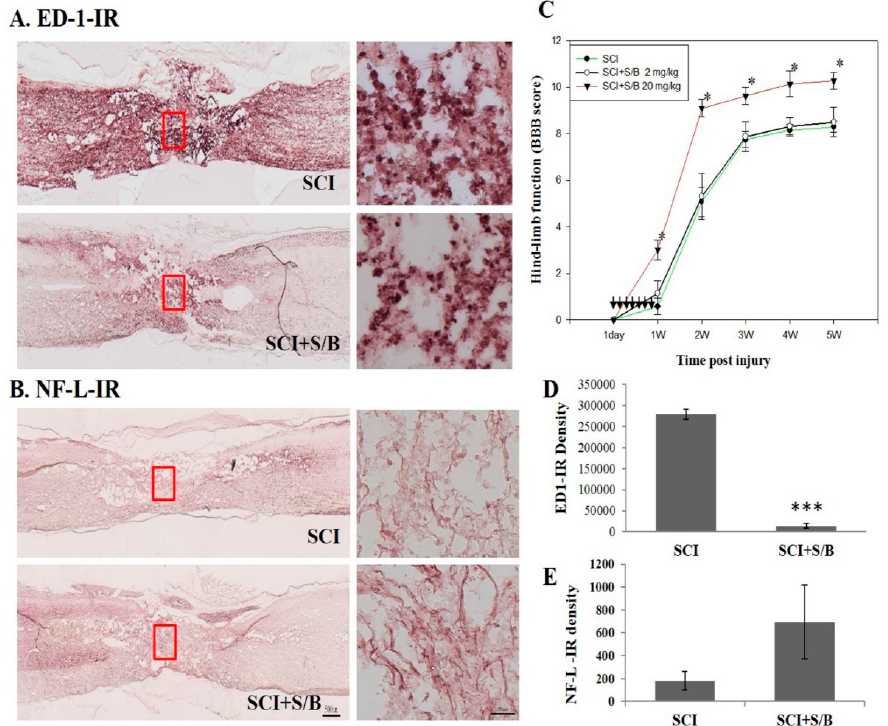
Figure 6. The microscope images of the neurofilament L (NF ‐ L) or ED1 ‐ immunoreactive (IR) spinal sections and the hindlimb functional restoration of SCI rats at 5 weeks after S/B remedy treatment , wherein ( A ) refers to the microscope images of ED ‐ 1 ‐ IR section of SCI or S/B remedy (20 mg/kg) ‐ treated SCI rats, ( B ) refers to the NF ‐ L ‐ IR in the injured spinal cords of two groups of SCI rats. Right images refer to higher magnification of the area marked by the red rectangles as shown in ( A ) and ( B ), respectively, ( C ) refers to the hindlimb functions of SCI rats in each group. Data are expressed as means ± SEM from N = 7, 4, 5 rats for SCI, SCI + S/B 2mg/kg, SCI+S/B 20 mg/kg, respectively, ( D ) and ( E ) refer to the quantitative results of ED ‐ 1 ‐ IR and NF ‐ L ‐ IR of SCI and S/B (20 mg/kg) ‐ treated rats. Adult SCI rats were intraperitoneally injected with 2 or 20 mg/kg of S/B for 7 consecutive days. The symbol “*” indicate statistical significance by one ‐ way ANOVA and Bonferroni t ‐ test for hindlimb function at P < 0.05 (SCI+S/B vs. SCI group). The symbols “***” indicate statistical significance by student t test for NF ‐ L and ED ‐ 1 IR at P < 0.0001 (SCI+S/B 20 mg/kg vs SCI).